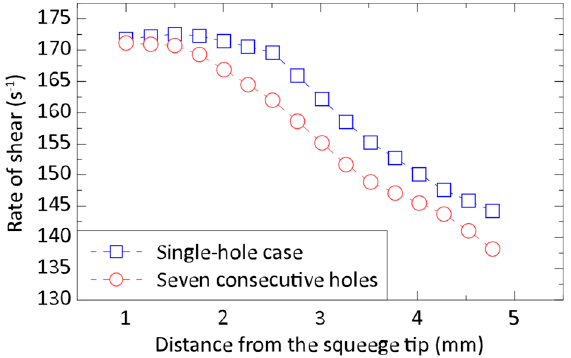
Figure 10. Rate of shear on the surface of the stencil at the proximity of the through-holes for the printing speed of 120 mm/s.